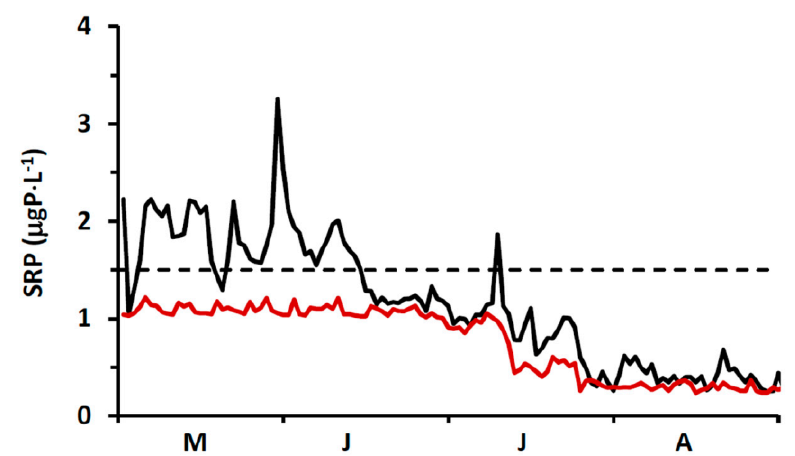
Figure 16. Model-simulated surface water SRP concentrations at a station proximate to the Duffin Creek WWTP outfall (see map inset, Figure 15). Simulations represent a multiple-source discharge with contemporary treatment and flow at the Highland Creek and Corbett Creek WWTPs and tertiary treatment and contemporary flow at the Duffin Creek WWTP (black line) and a sole-source discharge at the Duffin Creek WWTP with tertiary treatment and contemporary flow (red line). The dashed line represents the metric for P-limited growth (1.5 µ gP · L − 1 )